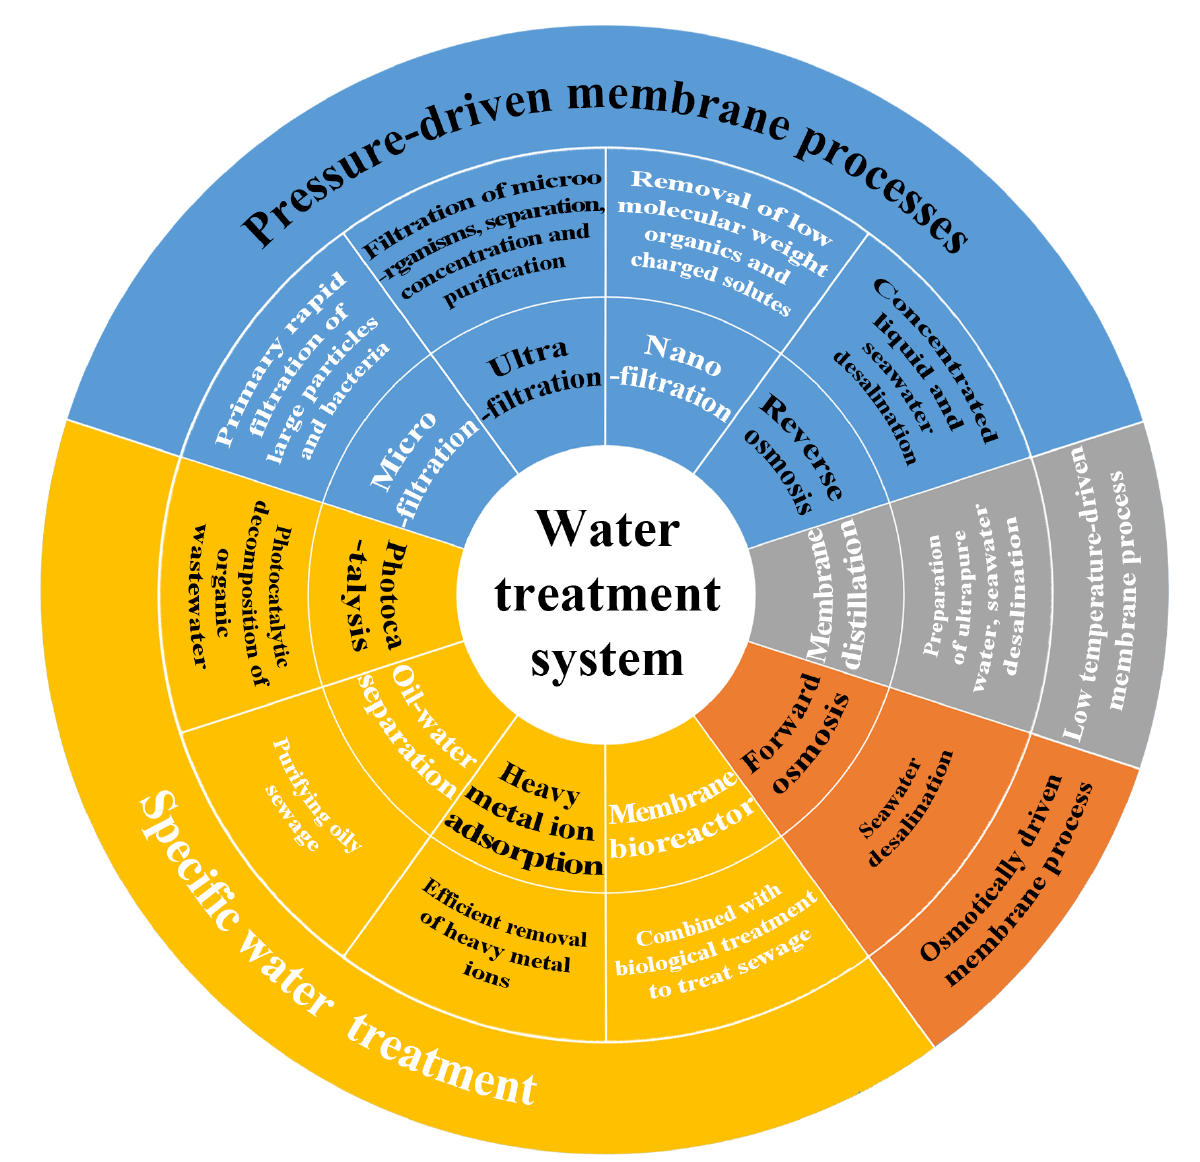
Figure 1. Classification of membrane separation techniques in water treatment systems.